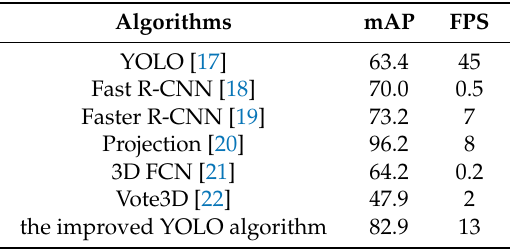
Table 4. Comparison of the training results of all